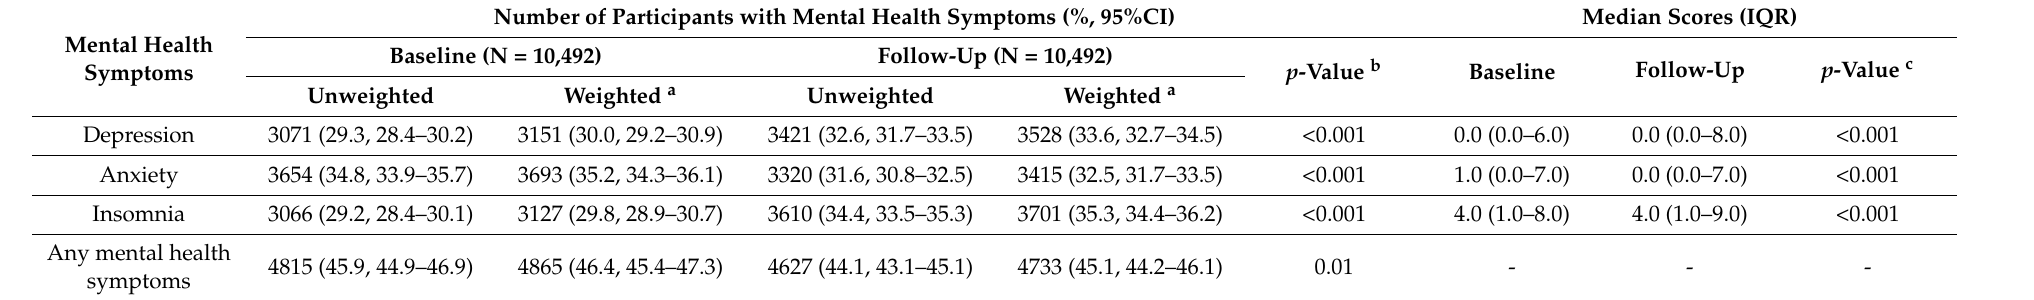
Table 2. Prevalence and scores of depression, anxiety, insomnia and any mental health symptoms at baseline and follow-up